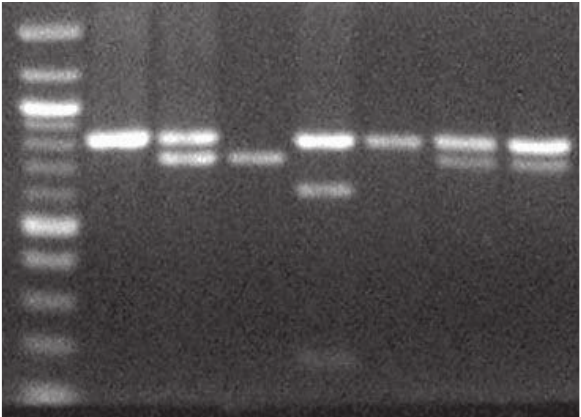
Fig. 6. ITS-RFLP patterns of single spore and dikaryot- ic isolates of I. jamaicensis using restriction endonucle- ase Hae III. Lane 1, size marker 100 bp ladder (high- intensity: 500 and 1000 bp); lane 2, amplicon; lane 3,